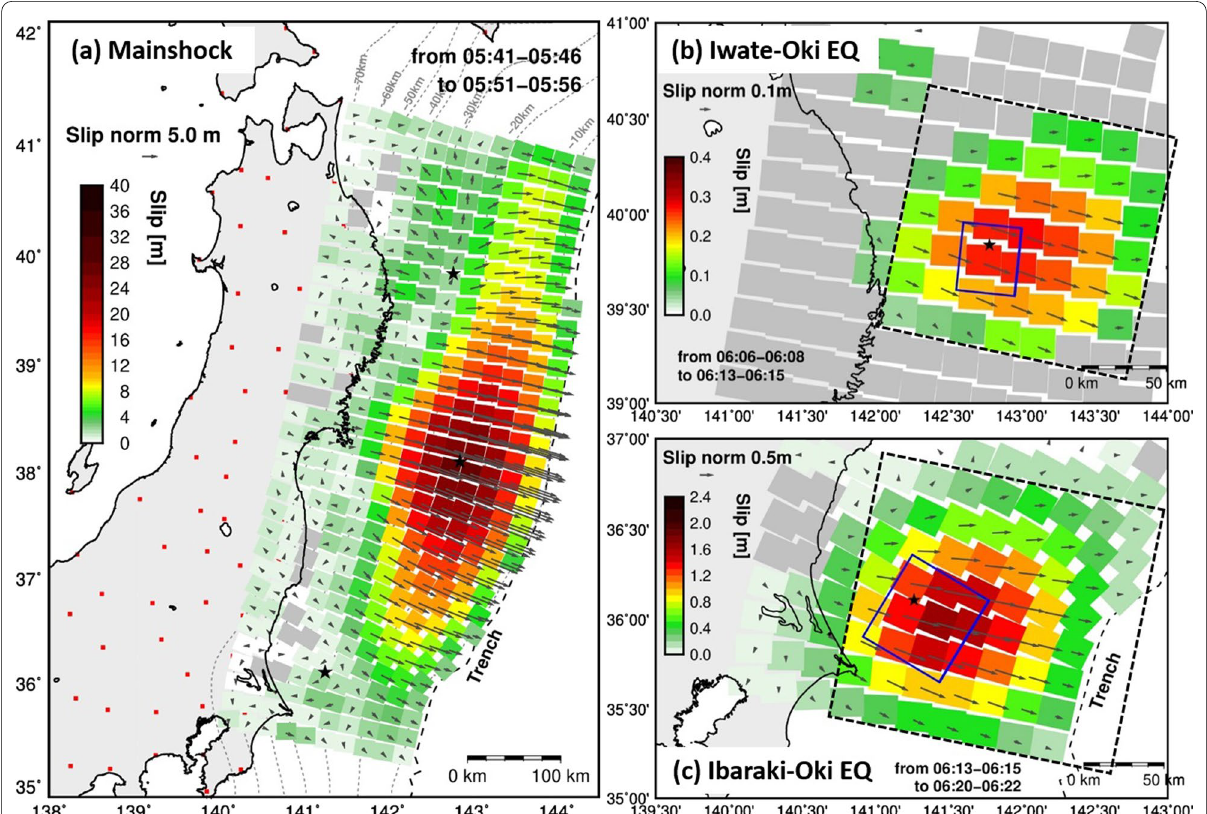
Fig. 5 Estimated coseismic slip distribution of the 2011 Tohoku-Oki sequence. Figures show the results for the mainshock ( a ), the Iwate-Oki EQ ( b ), and the Ibaraki-Oki EQ ( c ). The figure presents differences between the average of slip time series before and after the event origin (05:41–05:46 and 05:51–05:56 for the mainshock, 06:13–06:15 and 06:20–06:22 for the Ibaraki-Oki, and 06:06–06:08 and 06:13–06:15 for the Iwate-Oki, respectively). Black arrows represent the coseismic fault slip direction and norm. The slip amount of each subfault is indicated by the color gradation; darker colors denote more significant slip amounts. We excluded slip values that were smaller than their standard deviations estimated during Kalman filtering. The subfault was masked by gray when both components ranged below the standard deviation. The black stars represent the epicenters of the three earthquakes. The black dotted rectangle in ( b , c ) indicates the region of magnitude calculation. Please note that the scale of arrows and color differ for each figure. We also show the fault models estimated by Nishimura et al. (2011) by blue rectangles in ( b, c